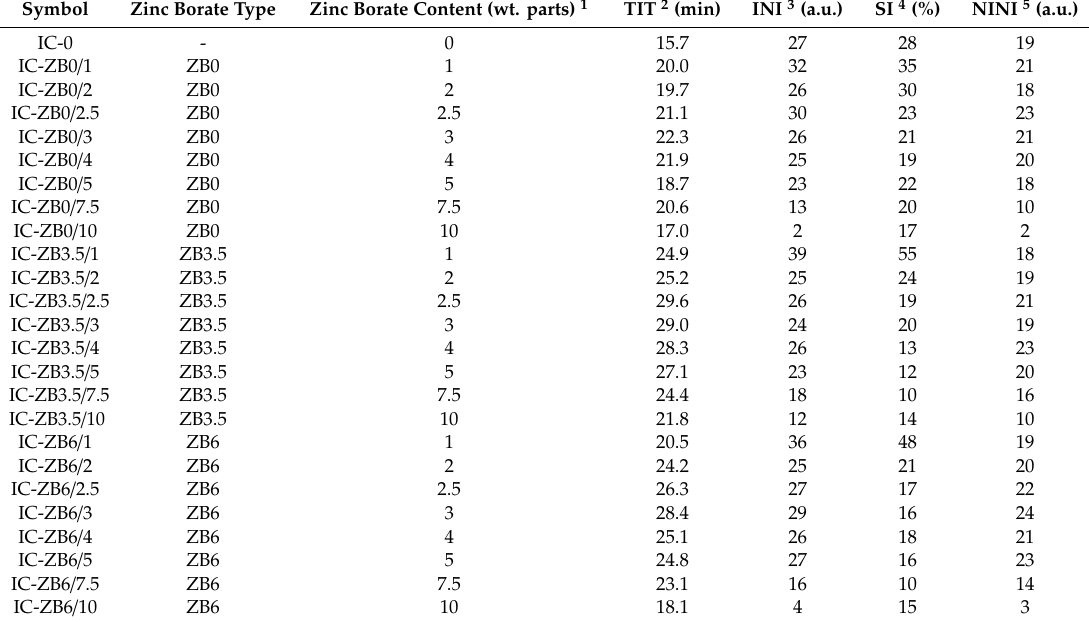
Table 2. Results of the furnace test of the intumescent coatings with various zinc borates. Symbol Zinc Borate Type IC-ZB0/7.5 IC-ZB3.5/1